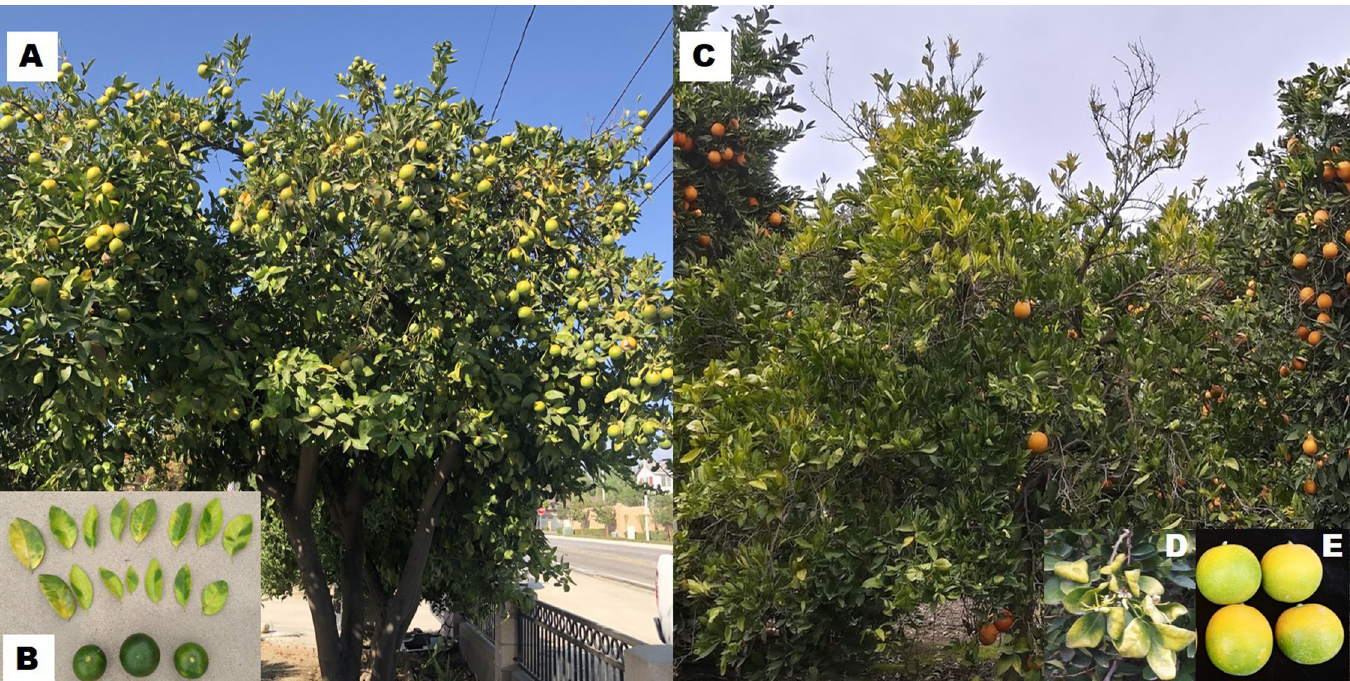
Fig 1. Comparison of qPCR-confirmed Washington navel tree infected with Huanglongbing (HLB) (Left) and Citrus stubborn disease (CSD) (Right). (A) C Las infected tree in suburban southern California; (B) Blotchy mottle leaves and distorted fruits symptoms of HLB. (C) S . citri infected tree (left) next to a healthy tree (right) in a field in central California; (D) Chlorotic leaves with shortened internodes and (E) smaller misshapen fruit, with seasonal stylar-end greening typical of CSD. HLB pictures provided by Magally Luque-Williams, CDFA.